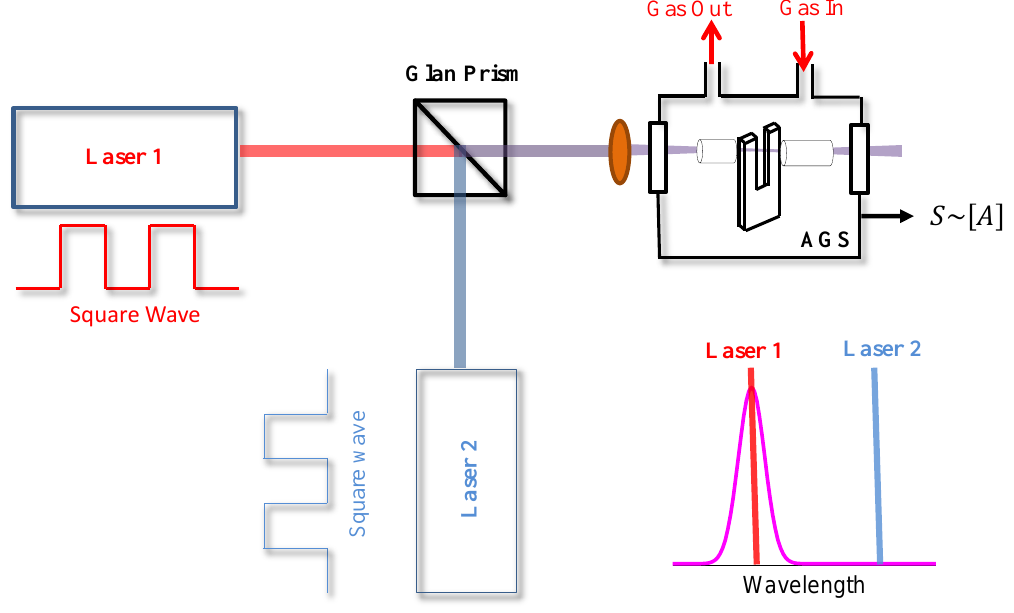
Figure 13. MOCAM method applied to the detection of broadband absorbers such as polyatomic molecules and aerosols. AGS – Analyzed gas sample. The signal S will be proportional to the target gas species concentration